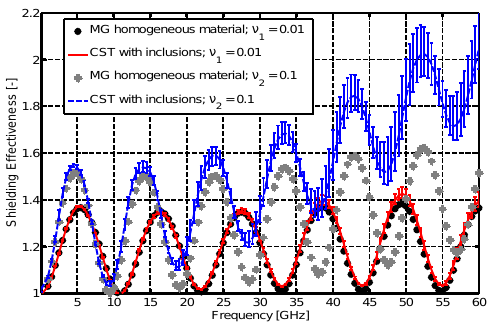
Figure 2: Effect of the volumetric rate of spherical inclu- sions on shielding effectiveness considering constant radius r = 0 . 050 mm and variable volumetric rates: ν 1 = 0 . 01 and ν 2 = 0 . 10